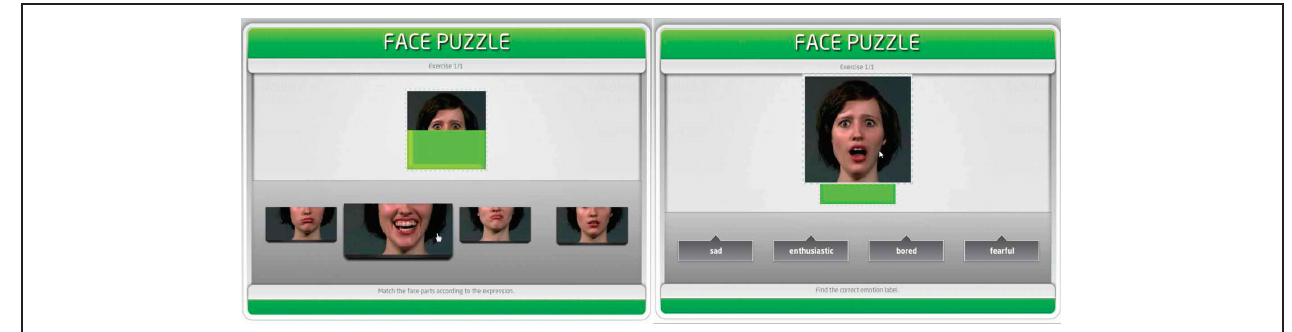
FIGURE 1 | Left: implicit task. Participants have to find the according mouth video to the target eye-video. Right : explicit task. Participants have to explicitly label the target emotional expression.